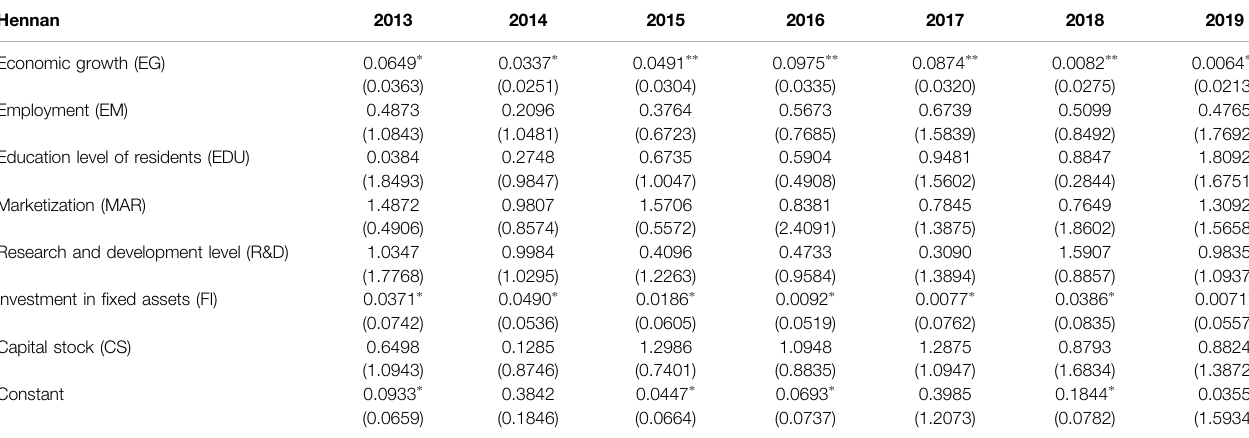
TABLE 19 | Driving force of Henan health tourism industry convergence. Hennan